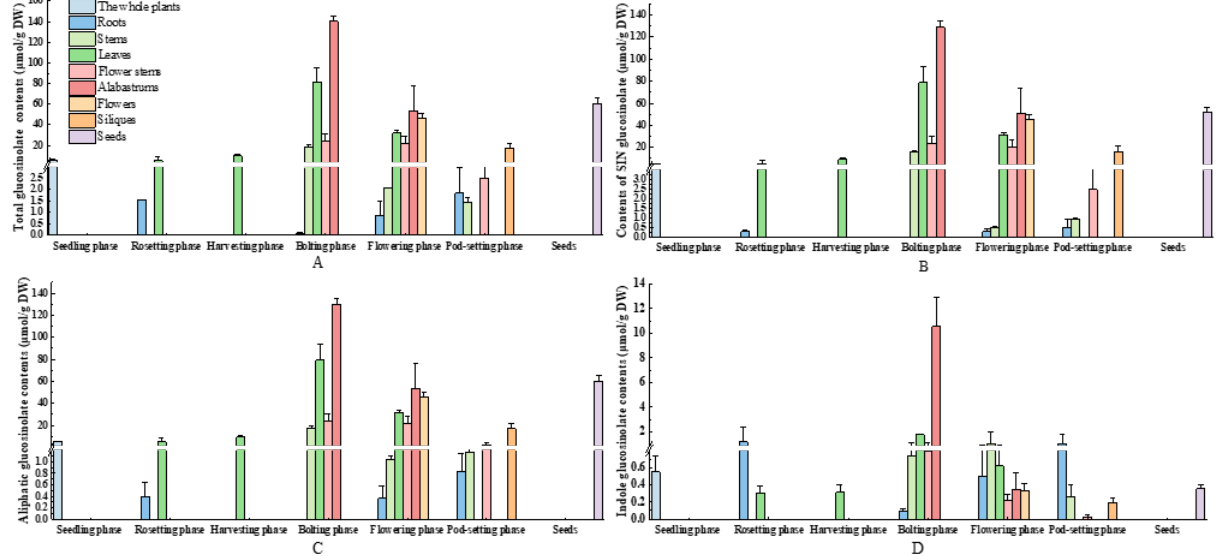
Figure 8. Differential distribution of glucosinolates among different parts in the same period in mustard JC 18-56: the total glucosinolate contents ( A ); sinigrin glucosinolate contents ( B ); aliphatic glucosinolate contents ( C ); and indole glucosinolate contents ( D ) of the whole plant, root, leaf, stem, flower stem, alabastrum, flower, silique, and seed tissues in the seedling stage, rosetting phase, harvesting phase, bolting phase, flowering phase, and pod-setting